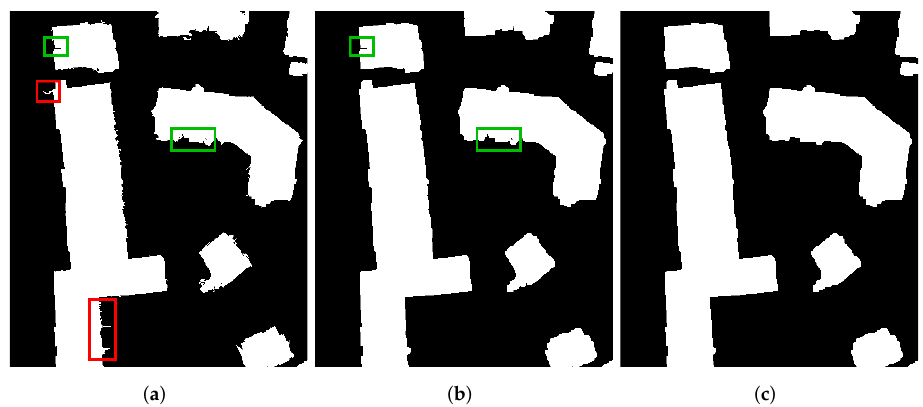
Figure 5. Illustration of postprocessing after the region matching of our building mask refinement method. ( a ): An enlarged building mask after our region matching method, which has the same spatial range as Figure 3a. ( b ): ( a ) after being processed by the second morphological opening operation. ( c ): ( a ) after being processed by both the second morphological opening and the second closing